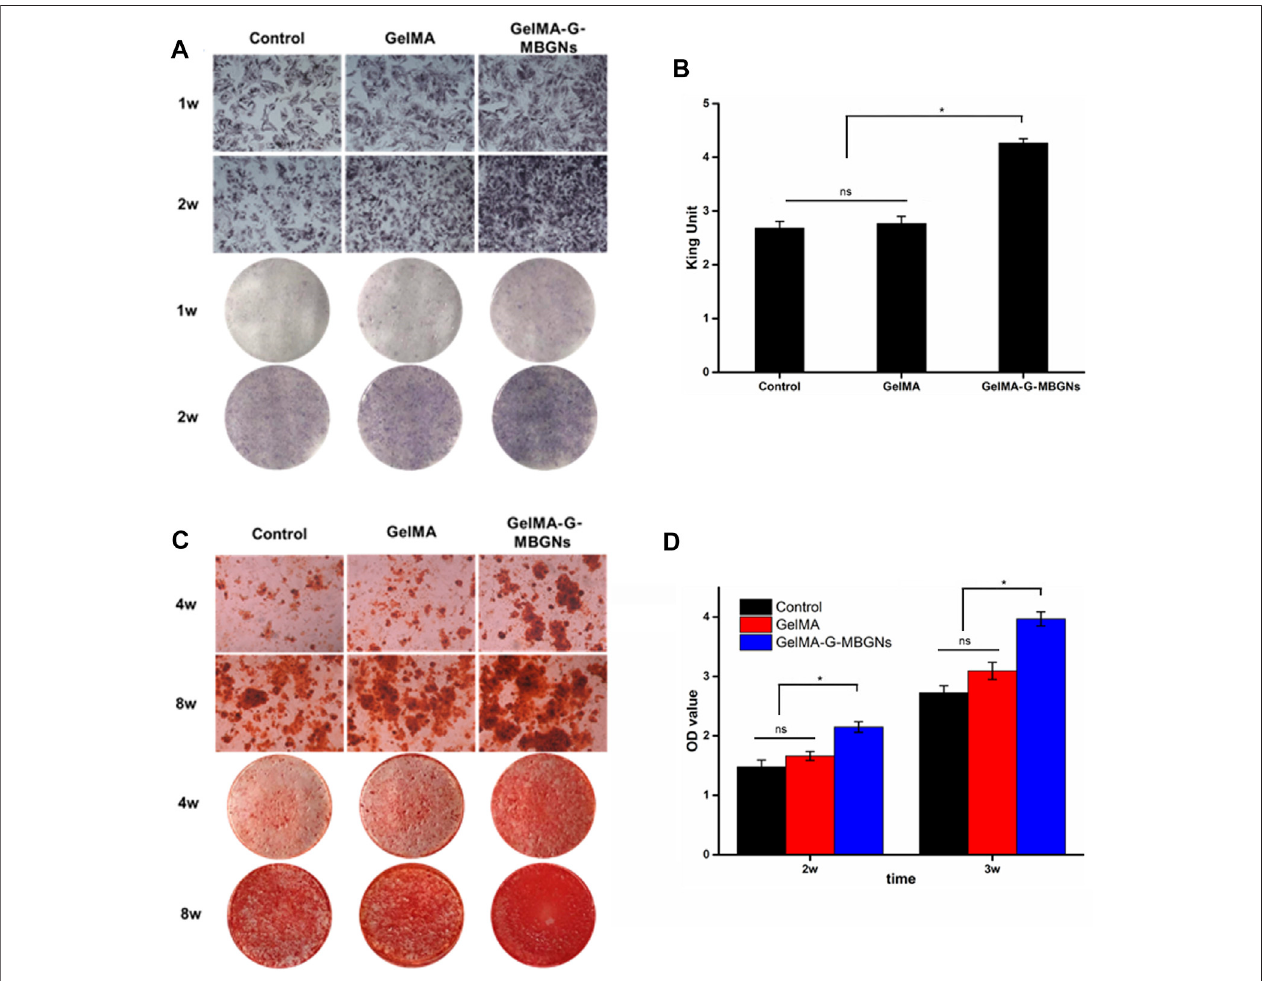
FIGURE 7 | Characterization of the osteogenic activity. (A) ALP staining images for the microscopic and gross view. (B) ALP quanti fi cation test. (C) Alizarin red staining images for the microscopic and gross view. (D) ARS staining quanti fi cation.